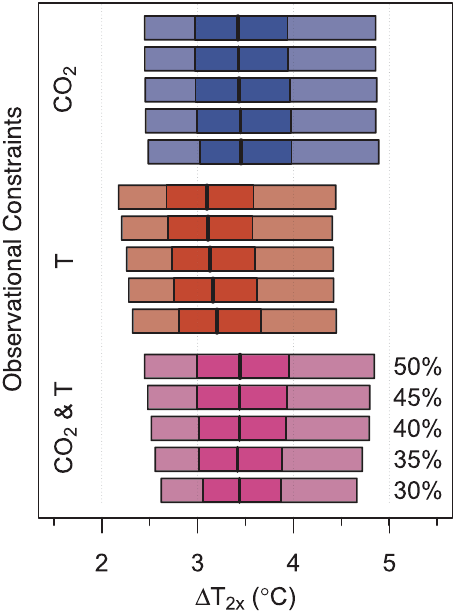
Fig. 3 Medians and 50 and 90% credible intervals of the ESS model parameter, Δ T 2 x . We use as observational constraints CO 2 only (top set of shaded blue boxplots), temperature only (middle set of shaded red boxplots), or both CO 2 and temperature (bottom set of shaded purple boxplots). Each boxplot shows the 5 – 95% (light shading) and 25 – 75% (dark shading) credible ranges and ensemble medians (solid lines). Within each set of boxplots, from top to bottom, the boxplots depict the credible ranges for the experiments using different thresholds for %outbound, starting with %outbound of 50% (top row in each set) and ending with 30% (bottom row in each set).